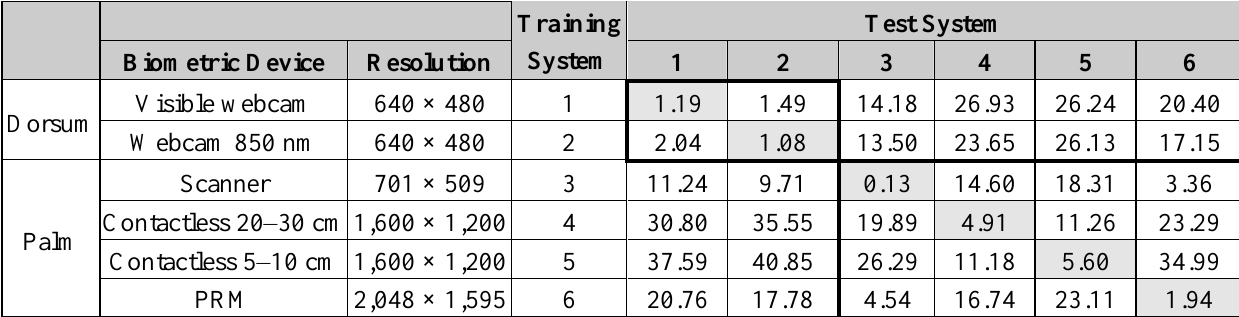
Table 4. Interoperability matrix for Finger-Geometry approaches in terms of EER